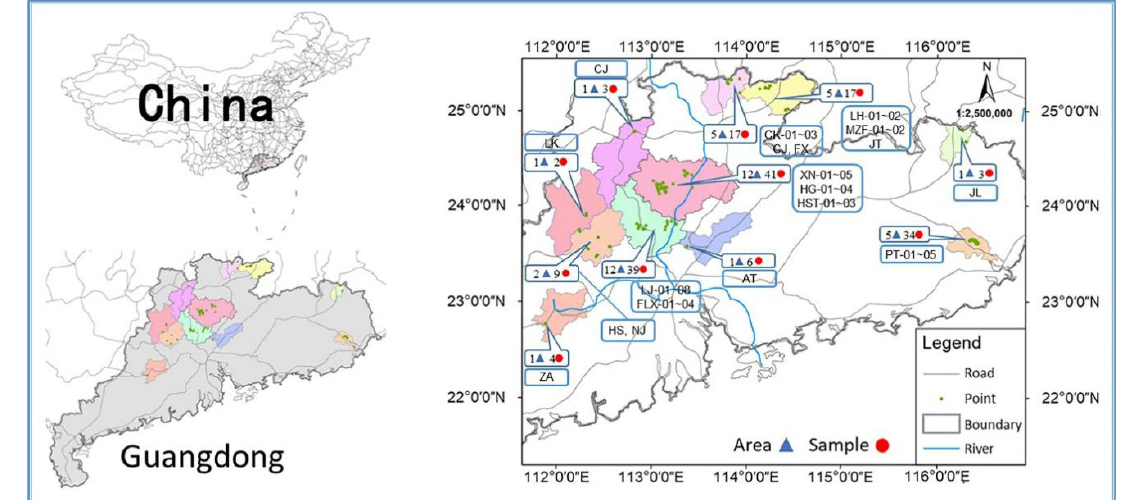
Figure 1. Location of the study area and sample point.